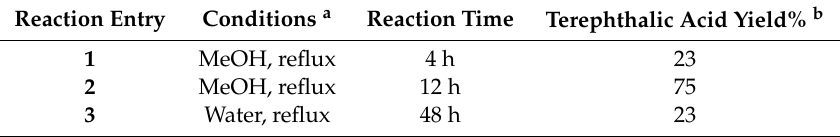
Table 1. Screening conditions for depolymerization of PET plastic.